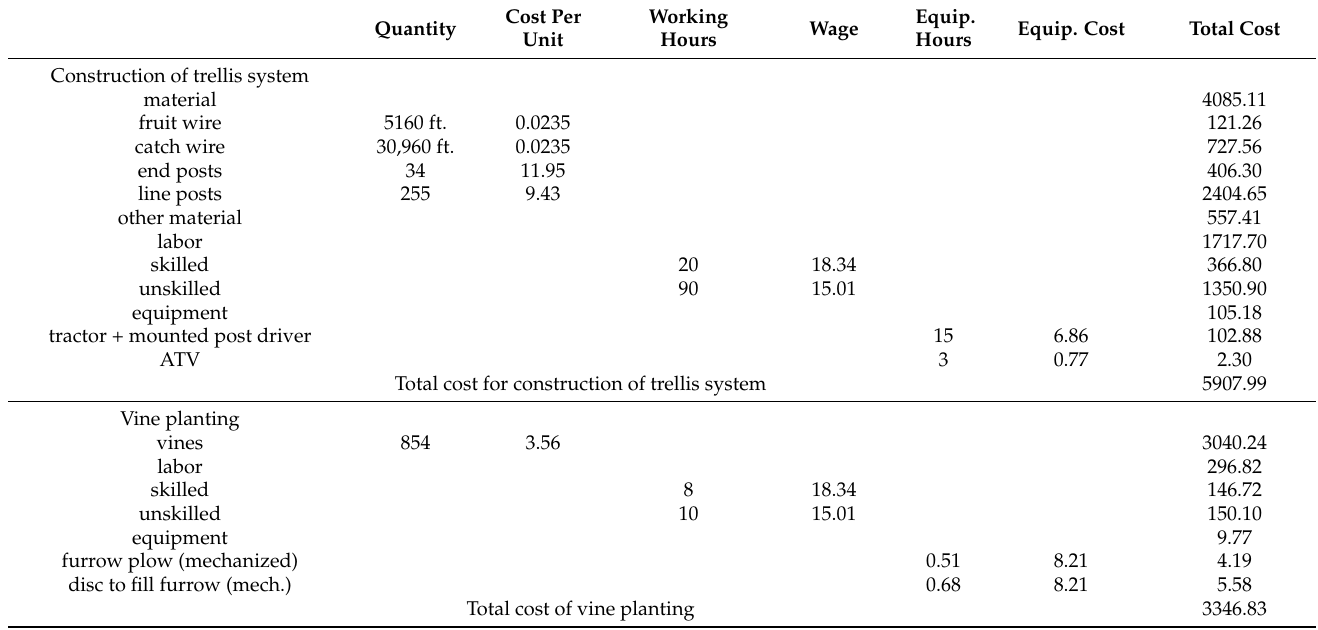
Table 5. Selected investment items for the establishment of a vinifera cultivar vineyard, per